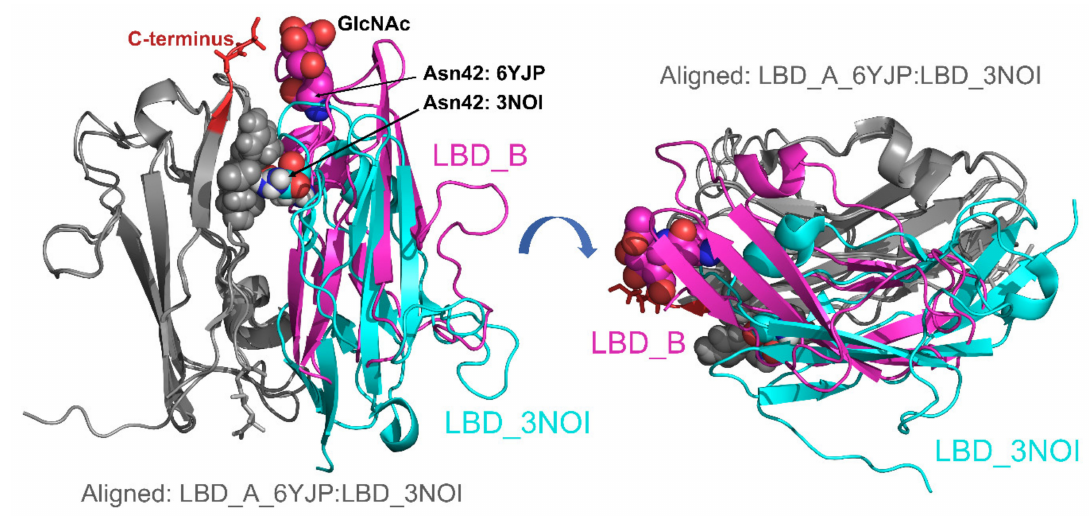
Figure 10. Glycosylation-induced NKp30 dimerization positions the glycans at Asn42 residues near the C-terminal stalk regions. The NKp30_LBD dimers observed in the present crystal structure PDB 6YJP and the PDB 3NOI [19] were aligned using molecules on one side of the dimer only (grey color). On the left —the N -glycosylation site at Asn42 of LBD_B, highlighted as spheres, is near the C-terminus of LBD_A (highlighted in red), whereas the Asn42 residue in LBD_3NOI is buried within the dimer interface, interacting with Glu26 and Arg28 (all highlighted as spheres). On the right—side view of the dimer interface showing the di ff erence in arrangement of the two